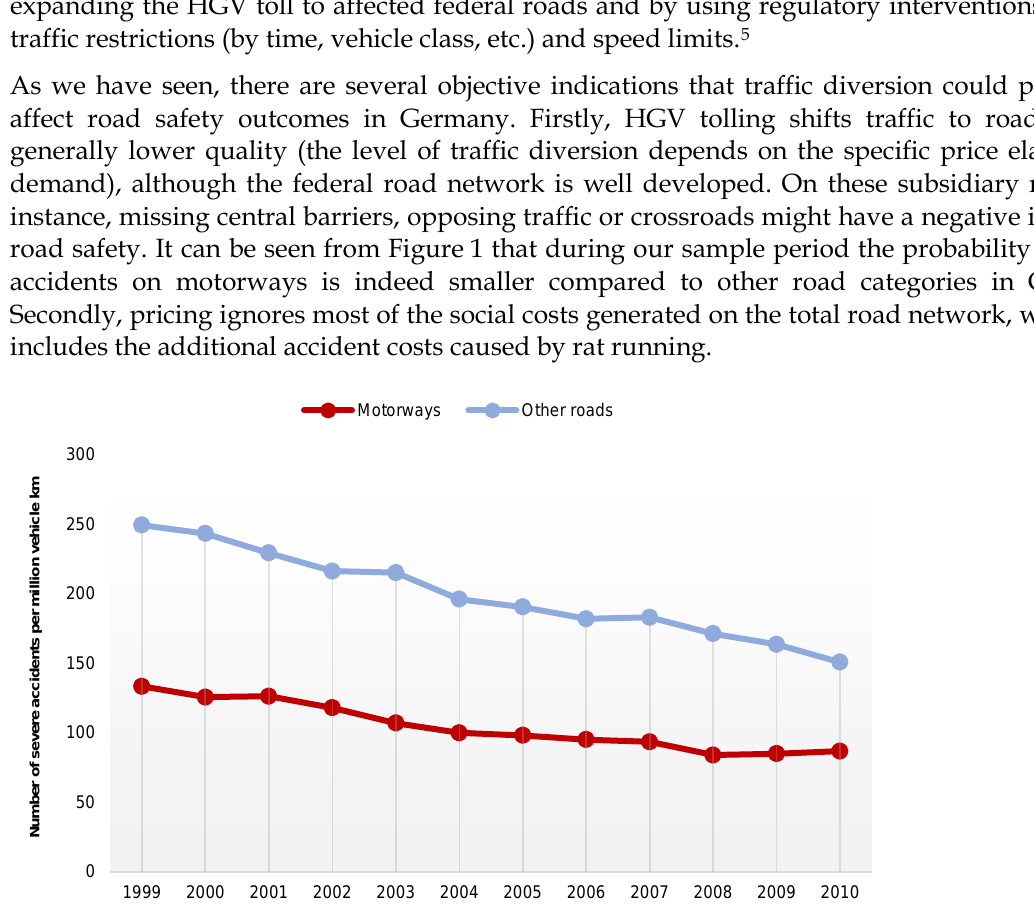
Figure 1. Number of severe accidents per million vehicle kilometres in Germany